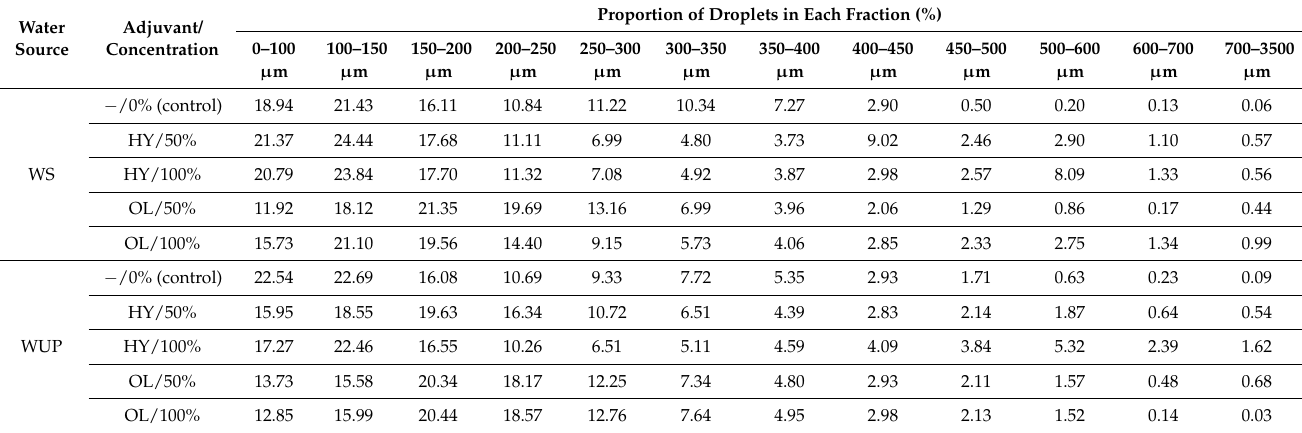
Table 7. Effect of water type, adjuvant type, and concentration on droplet size distribution.